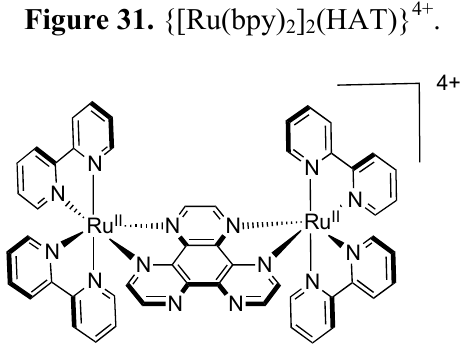
Figure 31. {[Ru(bpy)